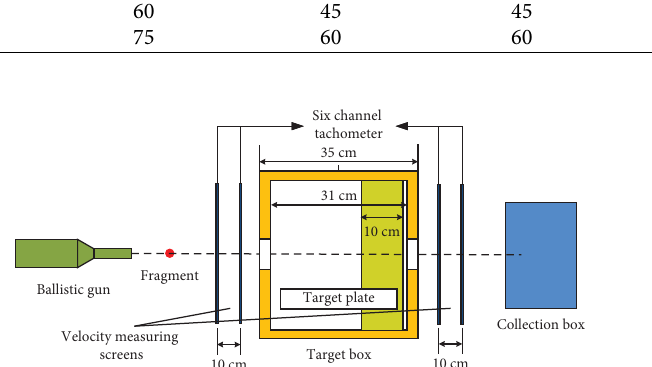
Figure 3: Schematic diagram of a test